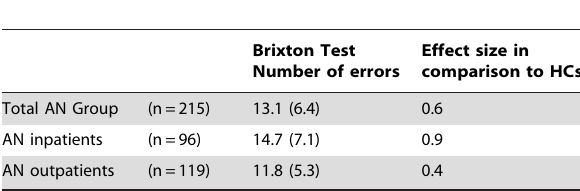
Table 3. Number of Errors on the Brixton Test made by Inpatients and Outpatients with Anorexia Nervosa.